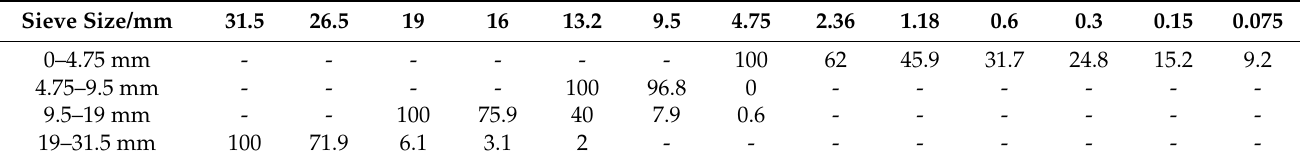
Table 8. Screening results of coal gangue aggregates with different particle sizes.